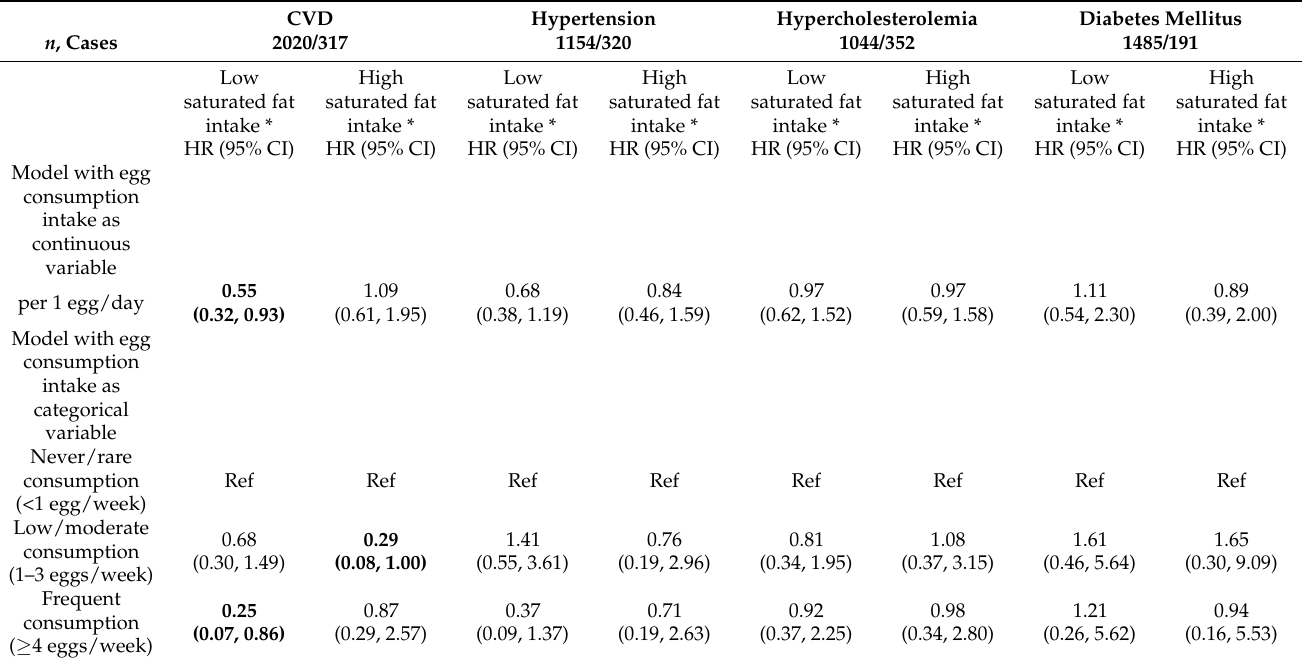
Table 4. Stratified analyses by saturated fatty acid